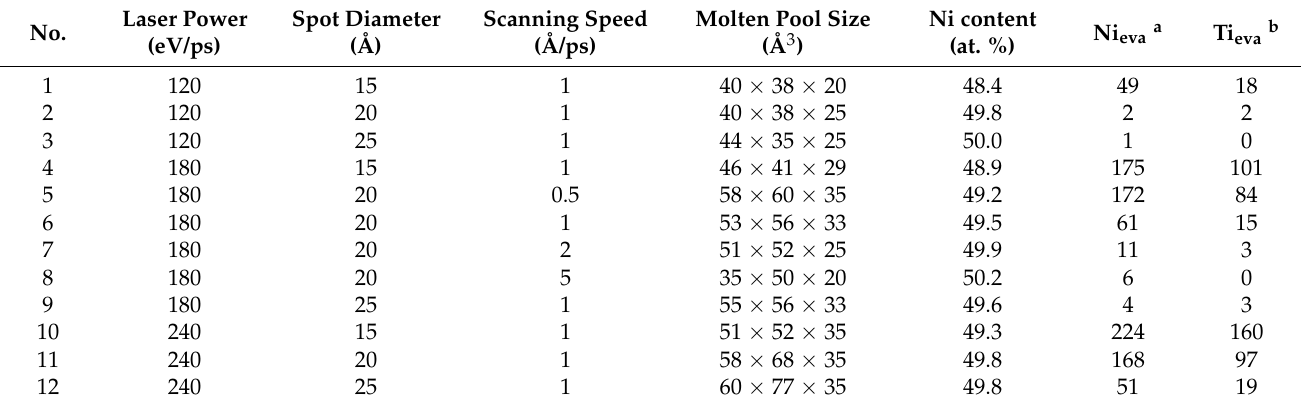
Table 1. The molten pool size, Ni content, and number of evaporated atoms at different process parameters used in the simulation.